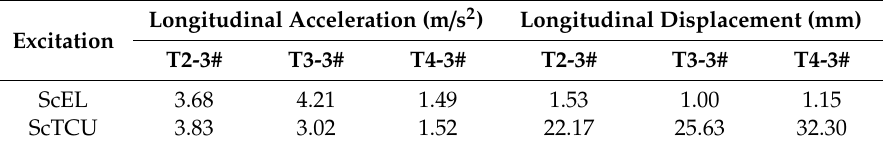
Table 6. The maximum longitudinal responses of 3# tower.